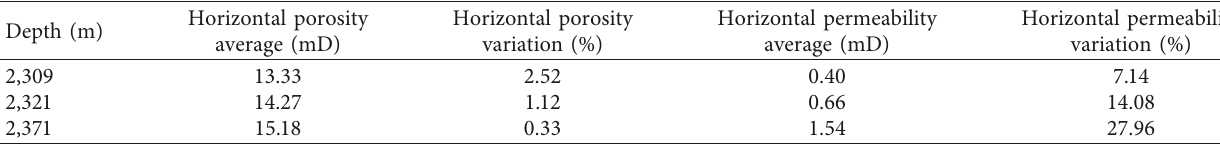
Figure 1: Scanning electron microscope images of tight reservoirs. Table 1: Variation of porosity and permeability of tight reservoirs in the horizontal direction.